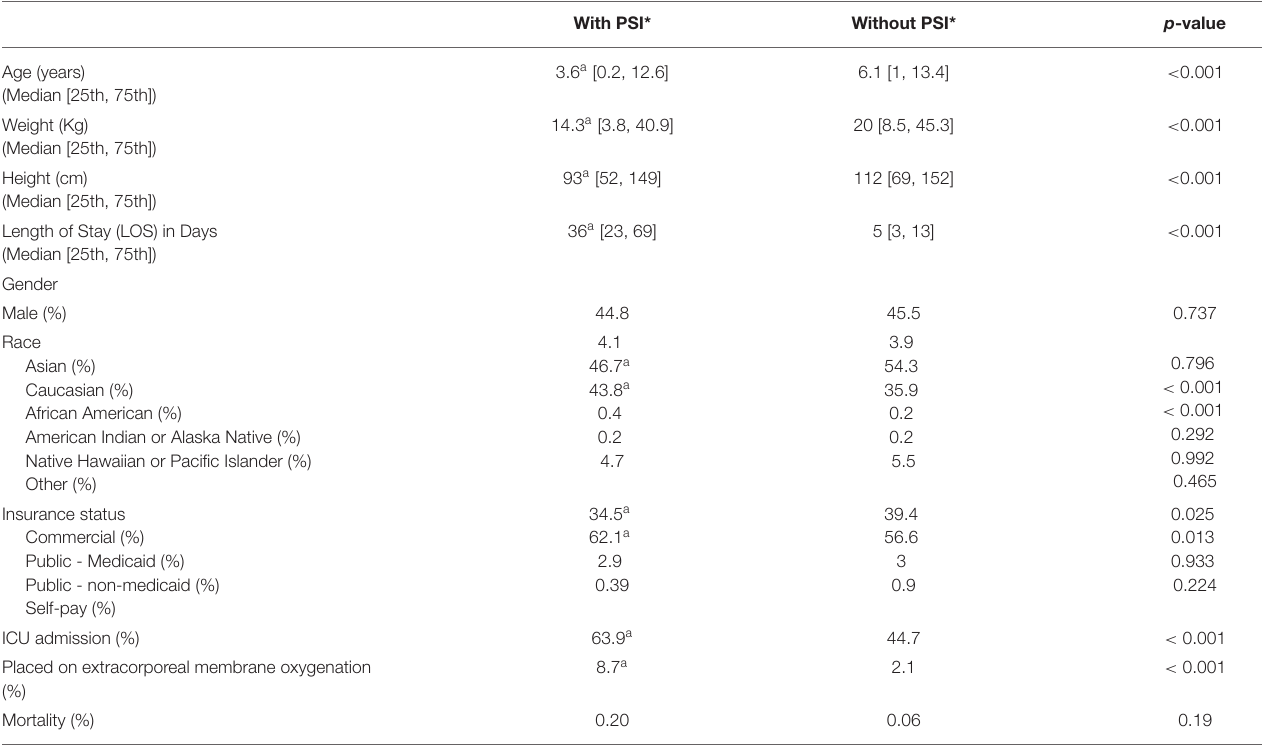
TABLE 1 | Cohort characteristics.